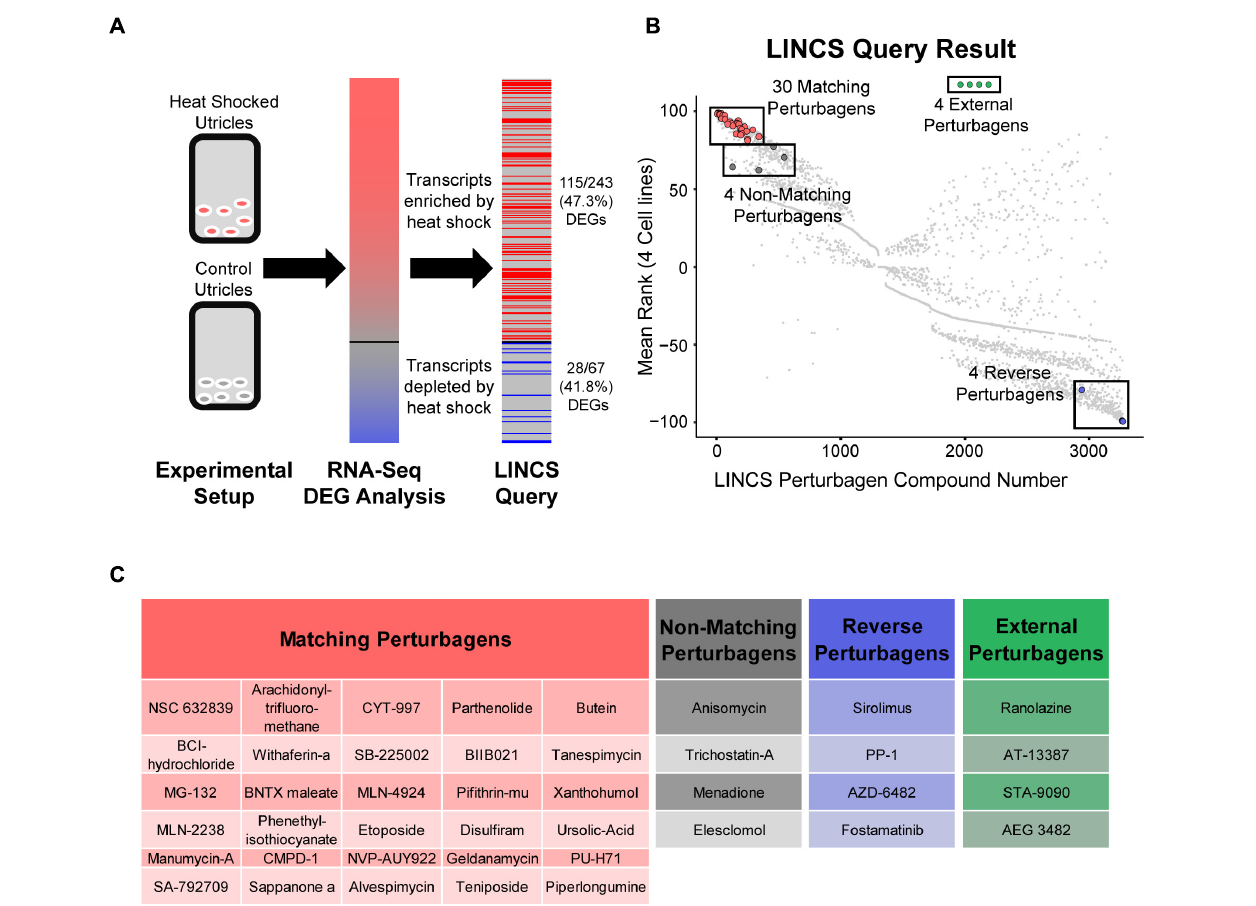
FIGURE 3 | LINCS identification of small molecule perturbagens that mimic the heat shock transcriptional signature. (A) Schematic of the LINCS workflow. Utricle cultures were analyzed by RNA-Seq to obtain a DEG signature of transcripts enriched or depleted by heat shock compared to control (red/blue gradient bar representing DEGs in Figure 1D and Table 1 ). The DEG signature was used as input for the LINCS Query tool, which recognized 115/243 (47.3%) enriched DEGs and 28/67 (41.8%) depleted DEGs. (B) Scatterplot of the 3,273 small molecule perturbagen signatures in the LINCS Query database showing the normalized rank match in four core LINCS cell lines compared to the input signature from heat shocked utricles. A subset of the LINCS-identified perturbagens was selected and screened for otoprotection and induction of the heat shock DEG signature. Thirty matching perturbagens (shown in red) were selected from the ≥ 90th percentile of all LINCS signatures that matched the input DEG signature of heat shocked utricles. Four perturbagens (dark gray) between the 80th and 90th percentiles were selected as non-matching perturbagens. Four perturbagens (blue) that yielded the opposite signature to the input DEG signature were chosen as reverse perturbagens. Four compounds (green) chemically similar to LINCS-identified compounds were added as external comparisons to the LINCS dataset. (C) The 30 matching perturbagen compound names are in red. The four non-matching perturbagen names are shown in gray; the four reverse perturbagen names are in blue, and the four external perturbagen names are in